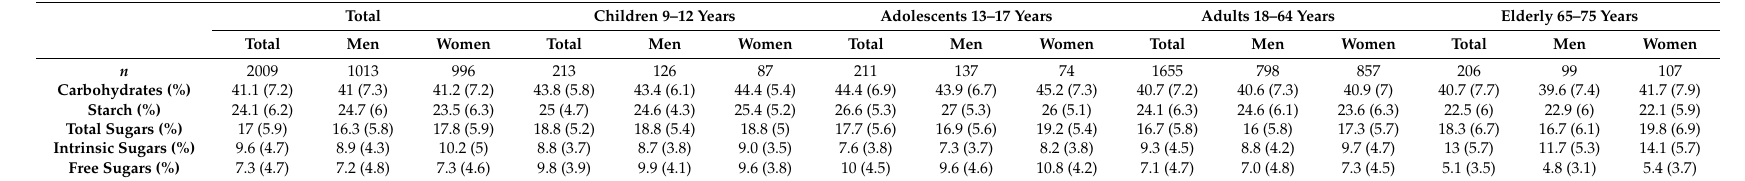
Results are expressed as the mean ± the standard deviation (in